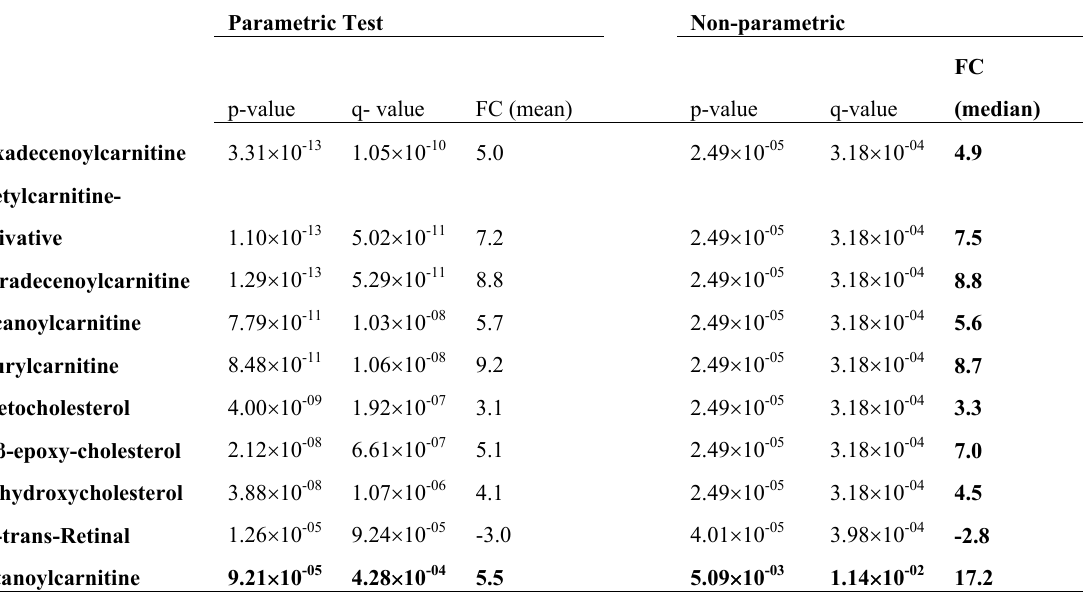
Table 4. Statistics summary of those metabolites identified using MS/MS experiments in working example #2. Unpaired t-test and Mann-Whitney test were used for parametric and non-parametric hypoxic and normoxic retinas comparison respectively. Correction for multiple testing was performed assuming 5%